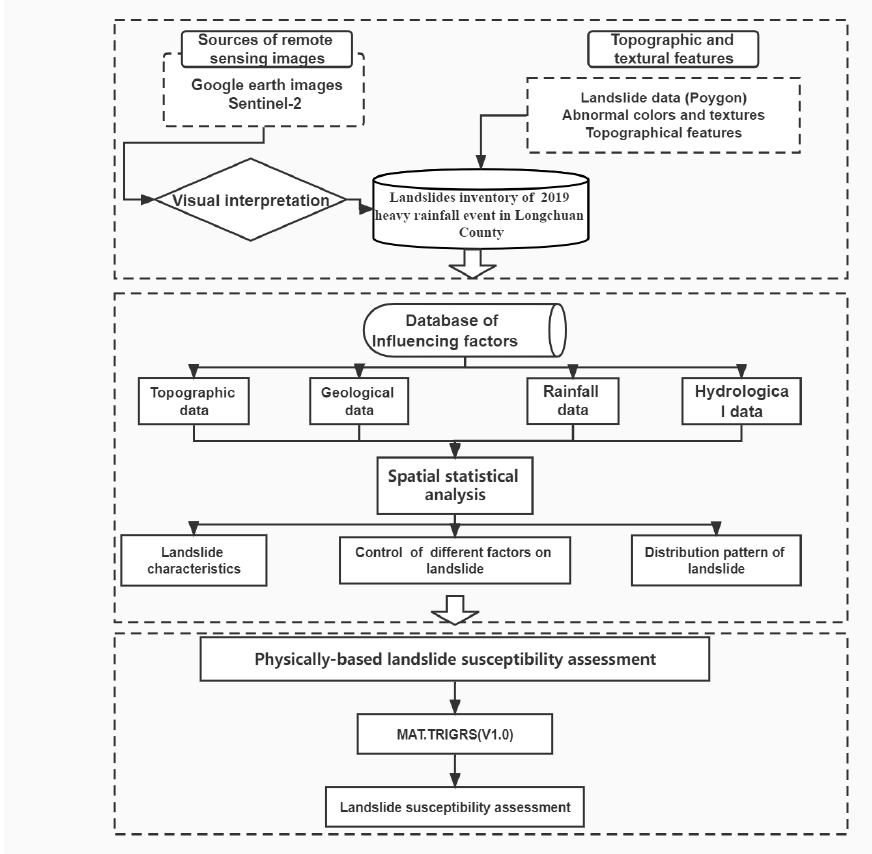
Figure 10. Flow chart of this study.